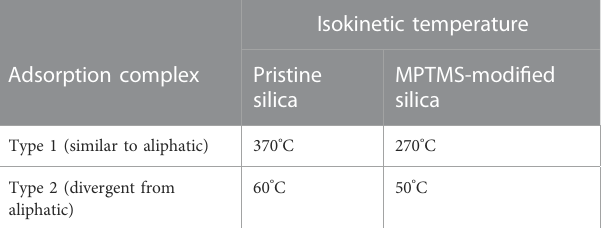
TABLE 4 Two different assumed adsorption complexes (type 1 and type 2) and the related isokinetic temperatures for probe molecules on the silica surface according to enthalpy – entropy compensation before and after surface modi fi cation.